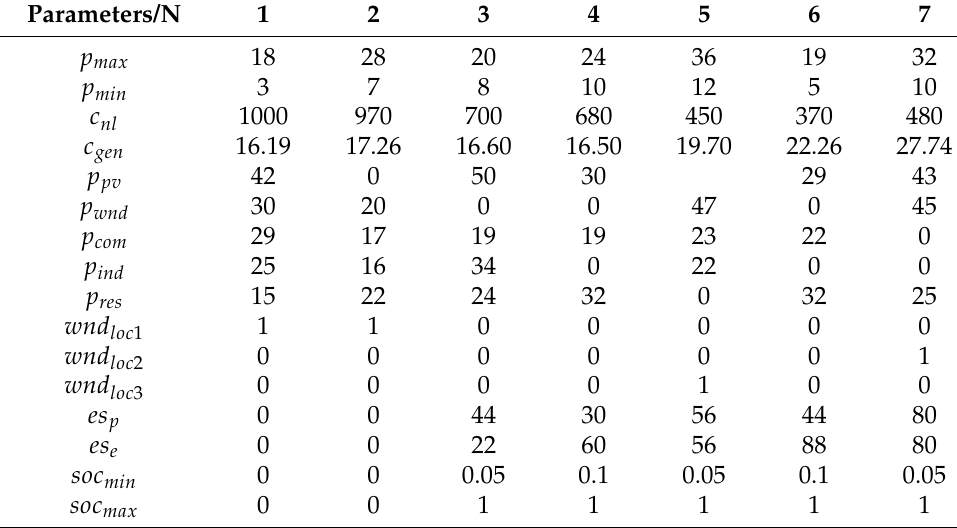
Table A10. Table representing the parameters in DS 3.